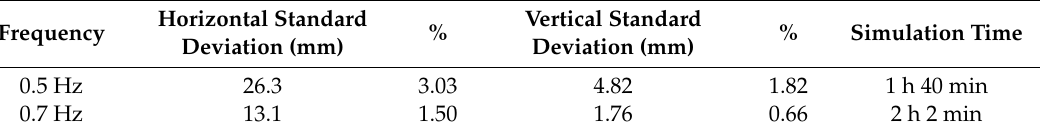
Table 2. Model output for the center of gravity ( Test 1 ).